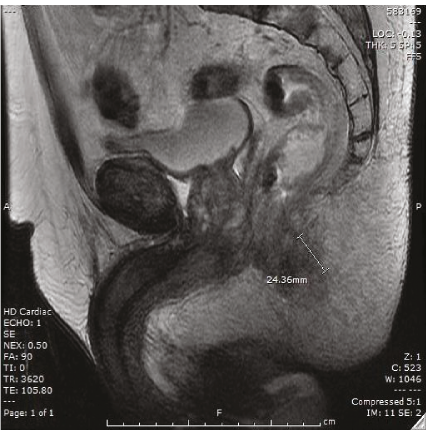
Figure 1: Lateral view of pelvic MRI showing in fl ammatory changes involving mucosa of the anus, rectum, and internal sphincter.